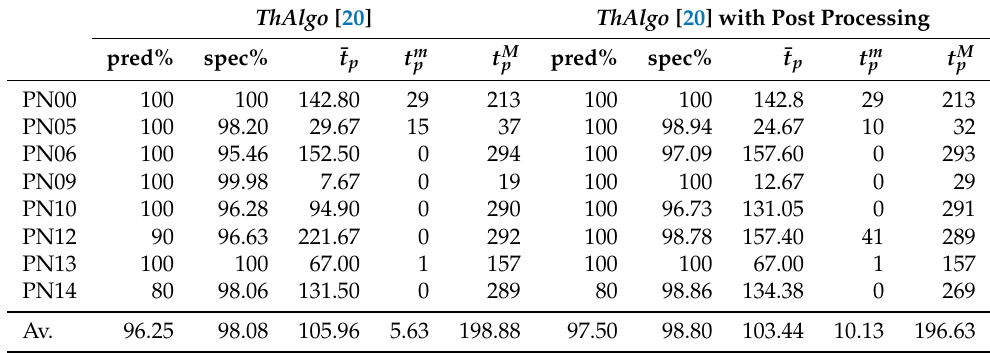
Table 3. Classification results of ThAlgo with and without postprocessing procedure with T = 300.